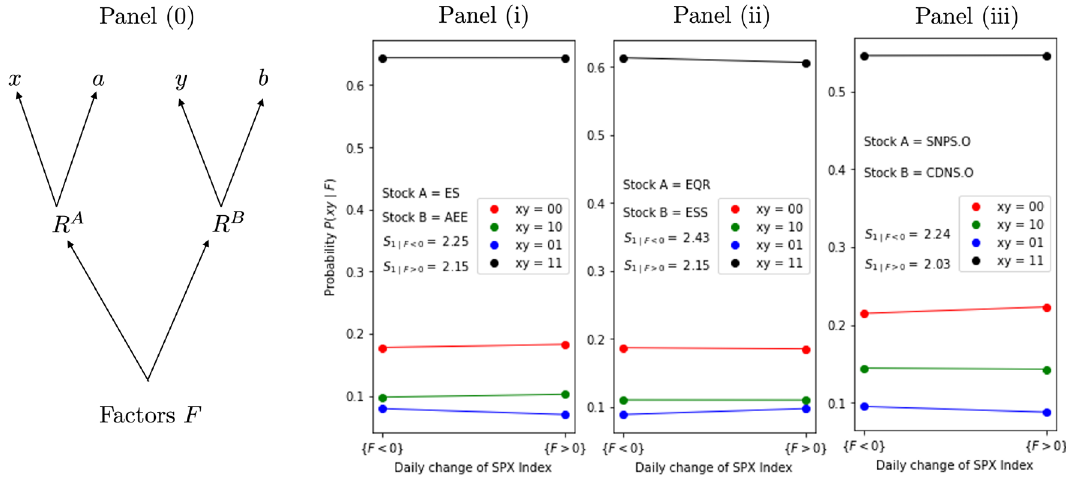
Figure 2. Factor Models. Panel ( 0 ) illustrates the Factor Model described in Eqs. (8) and (9), where the factors F generate the stock price returns R A and R B from which x , a and y , b are derived. Residuals are not shown in the diagram and appear as noise terms in the equations. Panels ( i ), ( ii ) and ( iii ) illustrate empirical tests of the factor model. These panels are based on the daily price change of the general S&P-500 market index as the explaining factor for market price change during the time period 4.5.2016 to 3.5.2019. Each of the three ) for the four regimes xy 00, 10, 01, 11 for a different pair of panels shows the conditional probabilities P ( xy |· = stocks. Again, a threshold of 1% is used to distinguish days with weak price change from days with strong price F < 0 ) , i.e. the probability on days with negative returns in the S&P-500, change. We compare the value of P ( xy | F > 0 ) , i.e. the probability on days with positive returns in the S&P-500. Horizontal lines in the against P ( xy | panels show equal probabilities. Panel ( i ) shows the stock pair ES (Eversource Energy) and AEE (Ameren Corp) with conditional S 1 -values of S 1 F < 0 = 2.25 and S 1 F > 0 = 2.15 . Panel ( ii ) shows the same analyses for the pair | | of stocks EQR (Equity Residential) and ESS (Essex Property Trust) , while the righthand Panel ( iii ) shows the analyses for the pair of stocks SNPS.O (Synopsys Inc.) and CDNS.O (Cadence Design Systems Inc.)